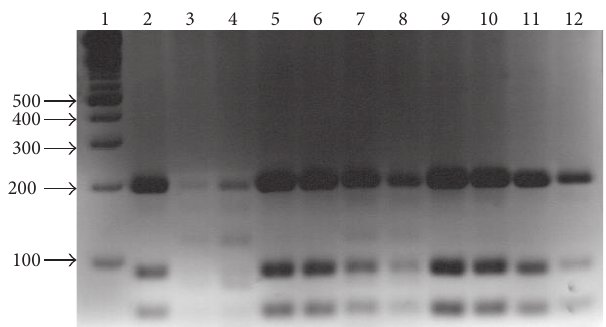
Figure 3: ITS1 PCR-RFLP of Clinical samples. Lane 1: MWMX174 Hae III ; lanes 2 to 12: clinical samples taken on filter paper or